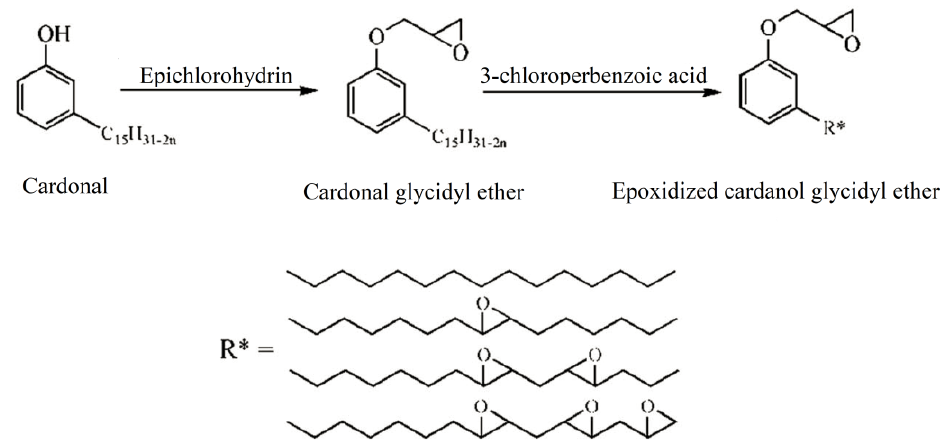
Figure 6. Synthesis of epoxidized cardanol glycidyl ether.